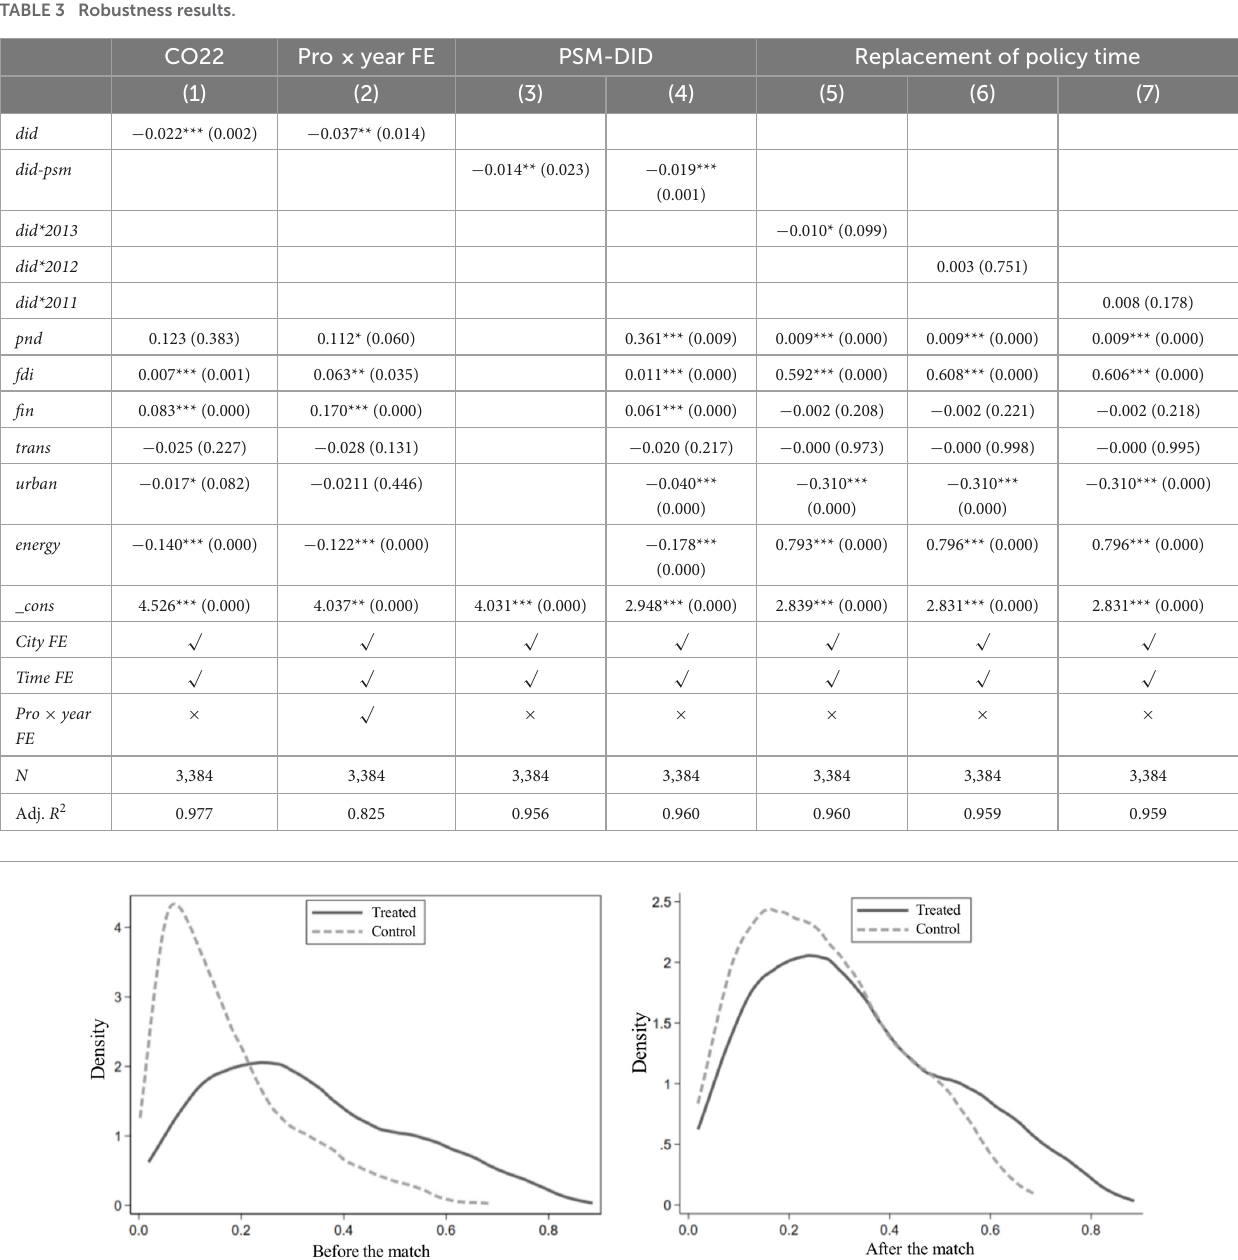
FIGURE2 Density function of the probability distribution of propensity score